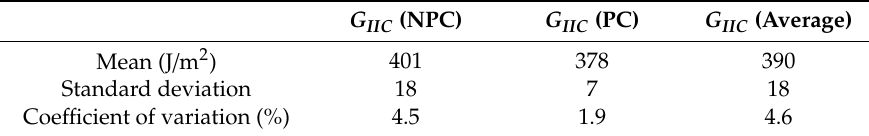
Table 3. Mode II fracture toughness values for UD FFREC.